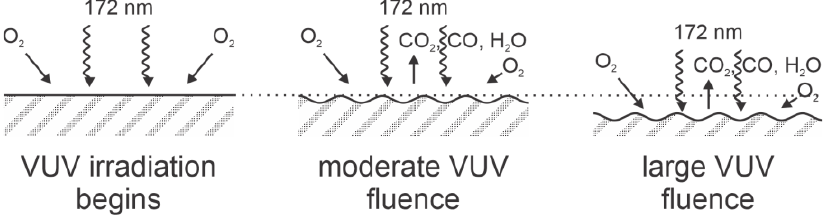
Figure 2. Schematic of the surface effects during PEEK treatment with VUV radiation from an Xe excimer lamp.